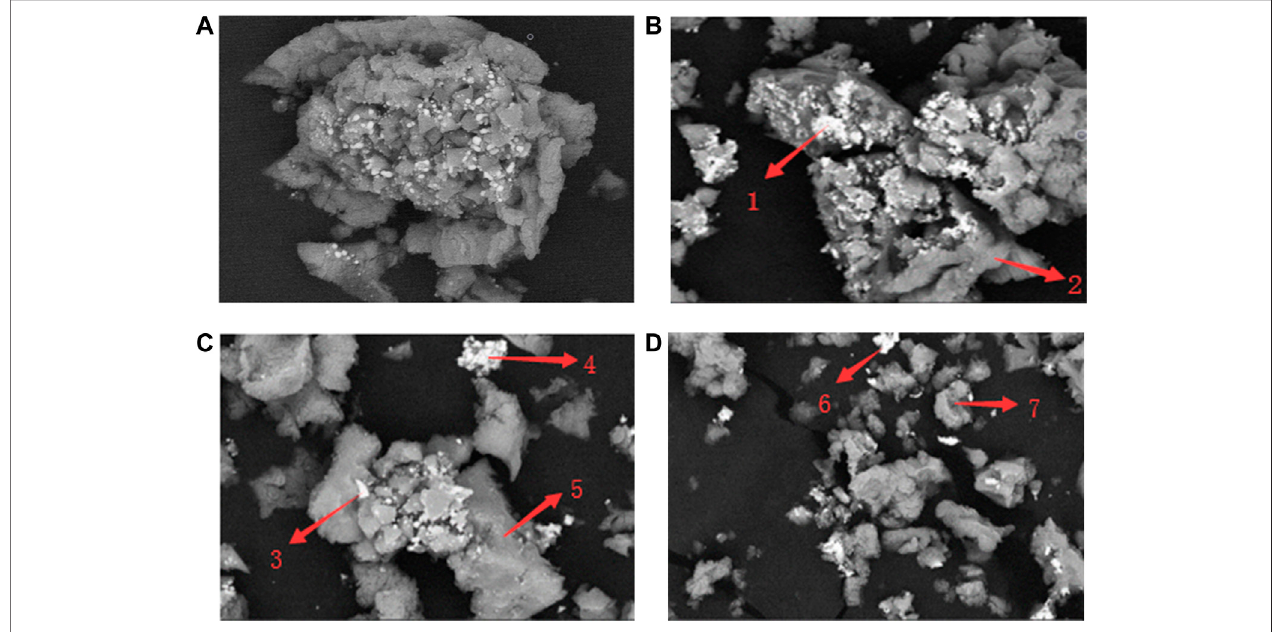
FIGURE 4 | SEM spectra of Ce-modi fi ed catalysts with different doping mass proportions: (A) 0%, (B) 3%, (C) 6%, and (D) 9%.